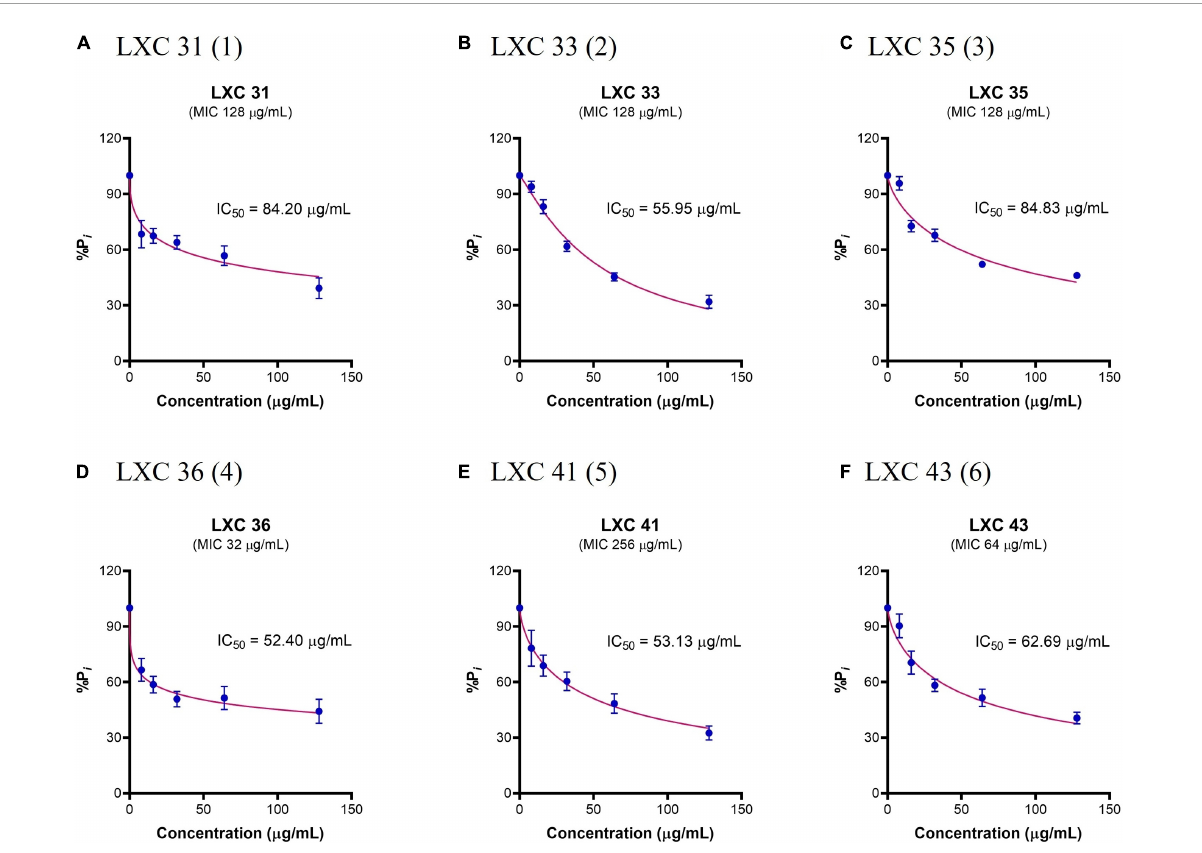
FIGURE4 The LXC compounds inhibit GTPase activity in a dose-dependent manner. (A–F) The GTPase activity of purified Ab FtsZ was determined from the liberation of P i from GTP using malachite green. Ab FtsZ was incubated with the LXC compounds for 30 min before the reaction was initiated by addition of 1 mM GTP. The reaction was terminated by the addition of citric acid after 10 min. P i release rate was normalized to the sample without the addition of LXC compounds (86.26 µ M P i /mg Ab FtsZ/min) that was taken as 100%. The results are presented in mean ± SEM. Statistical analysis was performed using one-way ANOVA (statistically significance, p < 0.05). A non-linear regression model was used in GraphPad Prism 8.3 to determine the IC 50